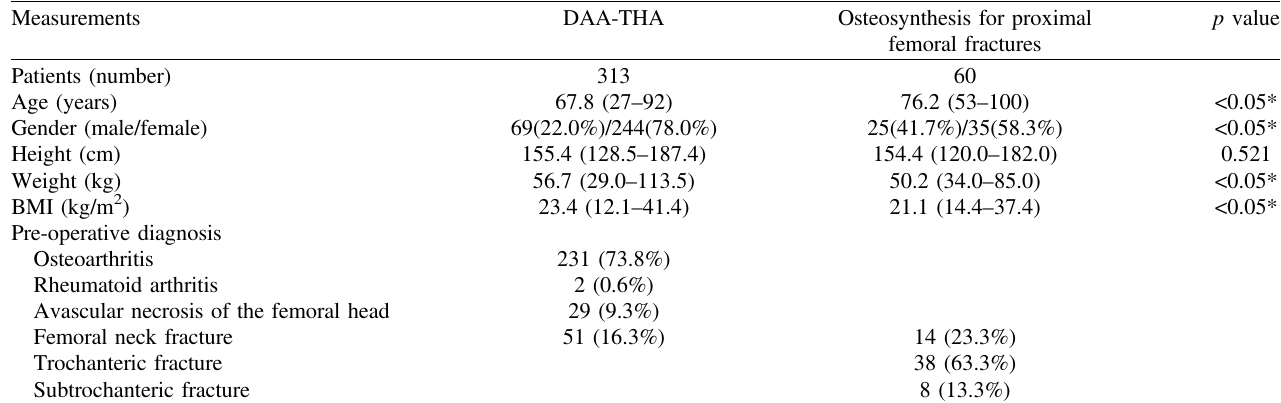
Figure 1. Simulation of DAA-THA by a phantom. Table 1. Patient characteristics.